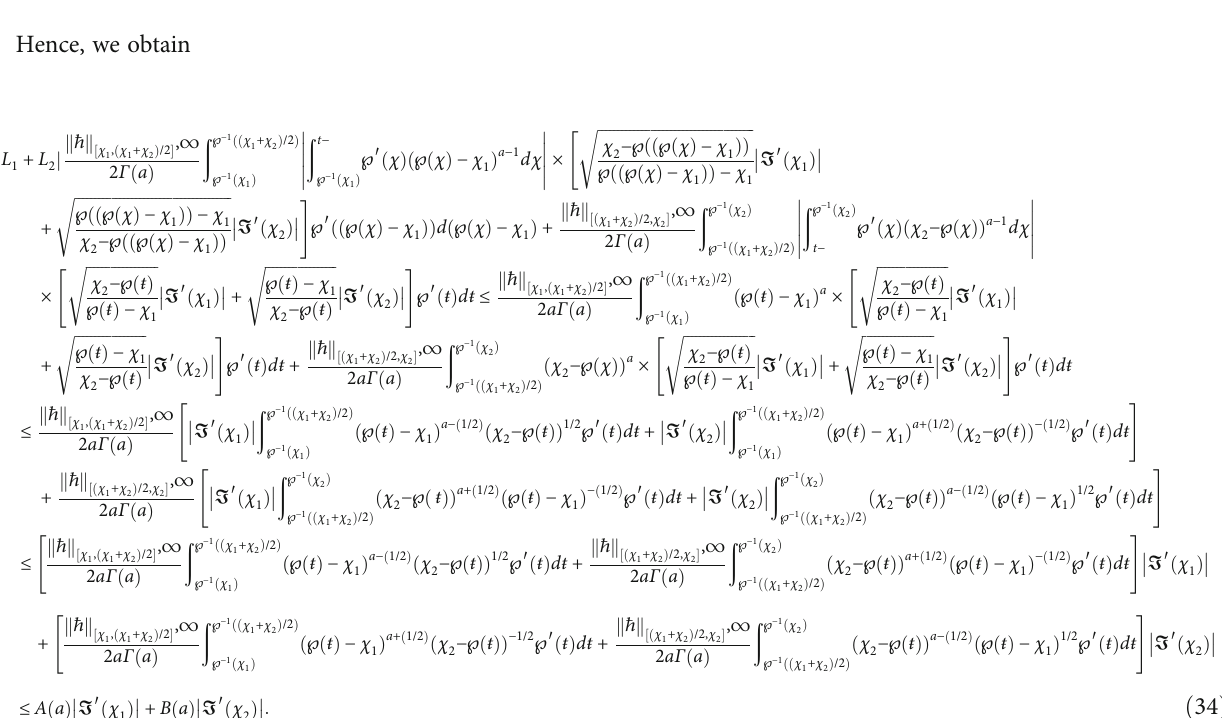
ffiffiffiffiffiffiffiffiffiffiffiffiffiffiffiffiffiffi ℘ ŧ ð Þ − χ